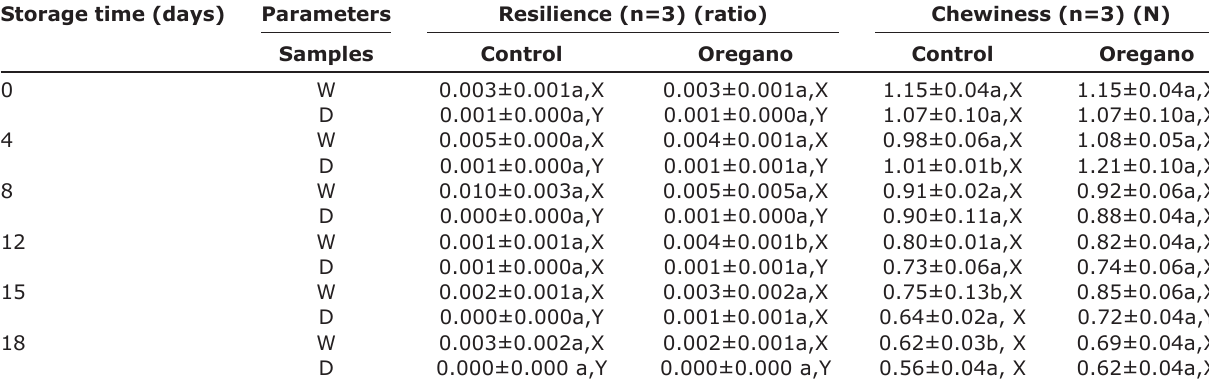
Table-5: Effect of oregano extract with vacuum packaging on the resilience and the chewiness of white (W) and dark (D) muscles of frigate tuna fillets stored at refrigerated (3±1°C) conditions. Storage time